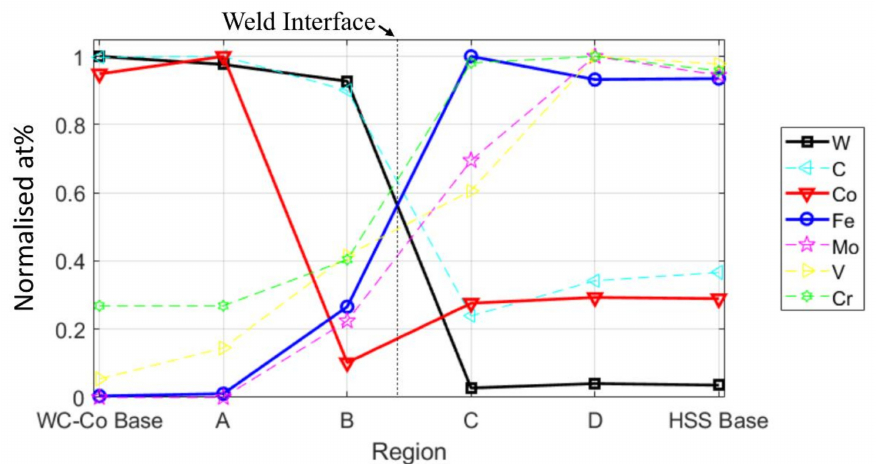
Figure 16. Concentration profiles of the main elements across the weld-line, based on the at% data listed in Table 2. The region selected for the EDS analyses is indicated in the SEI image of Figure 14.